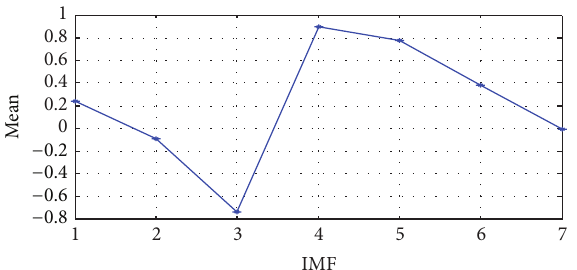
Figure 6: The mean of each IMF of uranium resource price monthly data series.